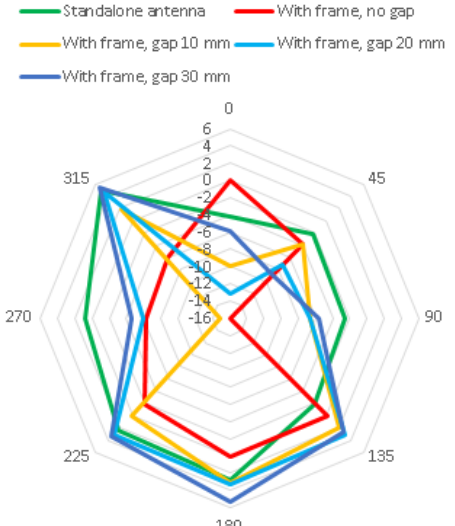
Fig. 4. Relative antenna gain depending on the configuration and orientation of the communication module and frame in horizontal plane.